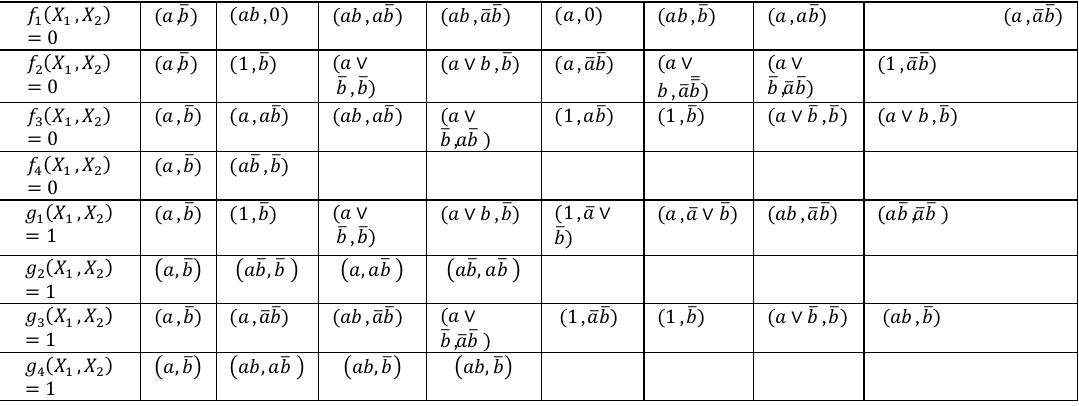
Table 1. A small set of Boolean functions over 𝐵